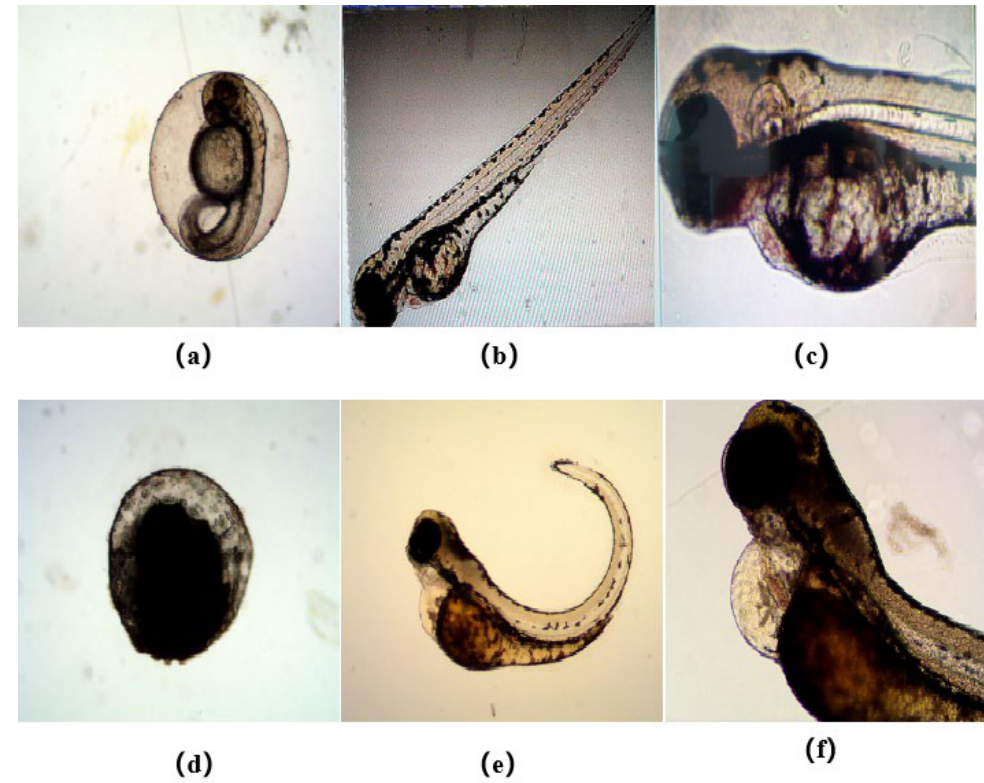
Figure 11. Normal and abnormal zebrafish embryos ( a ) Normal zebrafish embryos ( b ) Normal zebrafish ( c ) Normal pericardium of zebrafish ( d ) Embryo necrosis ( e ) Severe angulation of the spine ( f ) Severe pericardial edema.